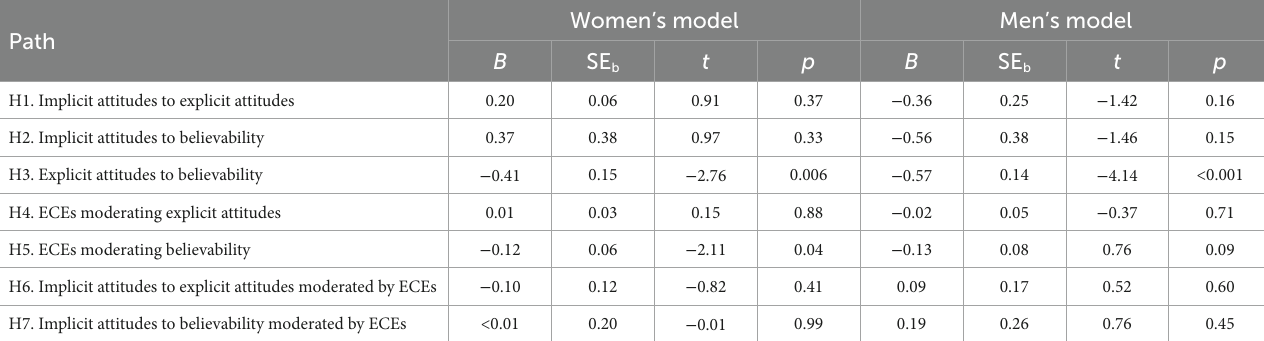
TABLE 3 Study one results for women and men’s